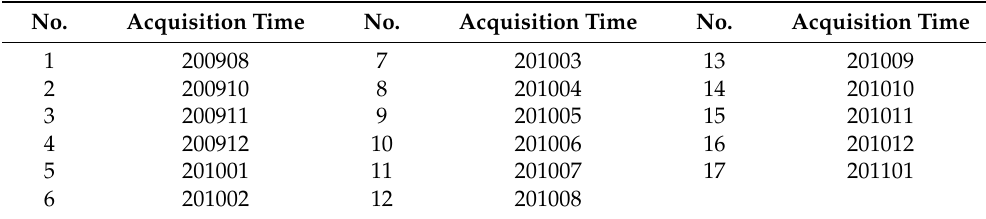
Table 2. Leveling data